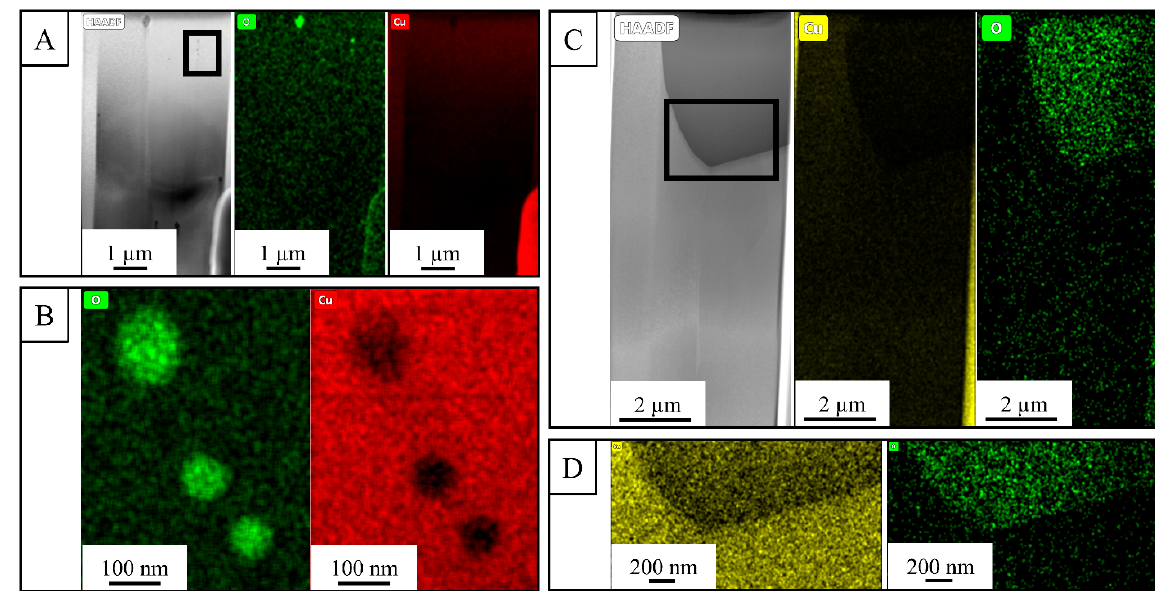
Figure 9. STEM EDS maps of an as-fabricated ( A , B ) and a HIP ( C , D ) specimen illustrating the size differences of copper oxide inclusions at the grain boundaries. Insets in ( A ) and ( C ) are shown in ( B ) and ( D ), respectively. Note the different length scales.